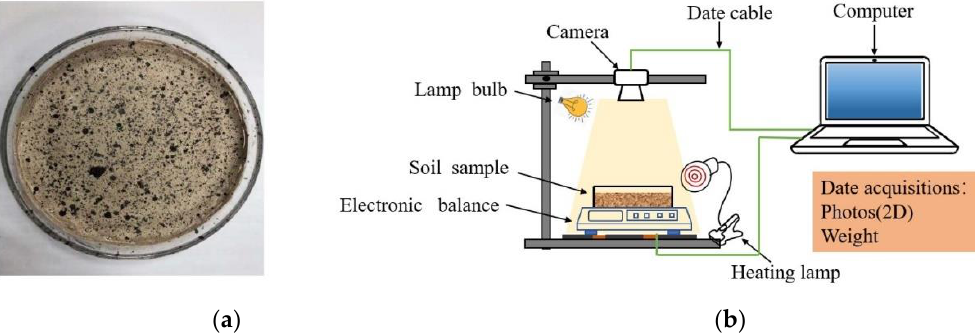
Figure 3. Schematic representation of the drying shrinkage crack test setup: ( a ) speckle specimens; ( b ) schematic diagram of test device.